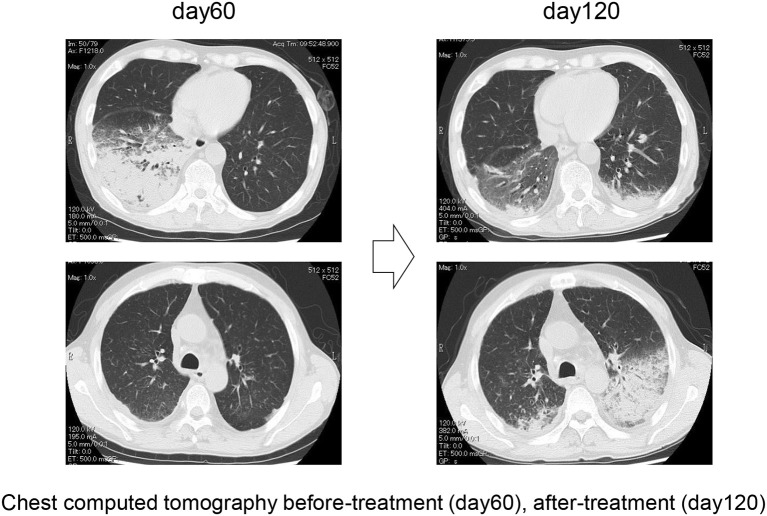
Representative chest computer tomography of case 1, showing consolidation in the right lower lung field at day 60 and consolidation in the left lower lung field at day 120.